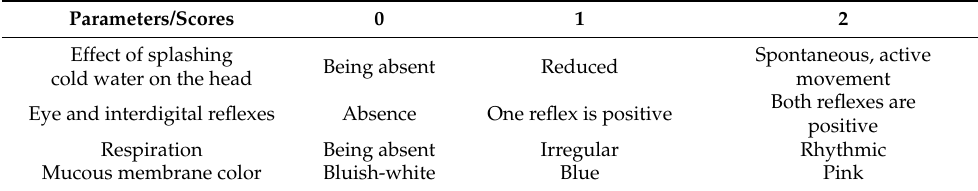
Spontaneous, active movement Both reflexes are positive